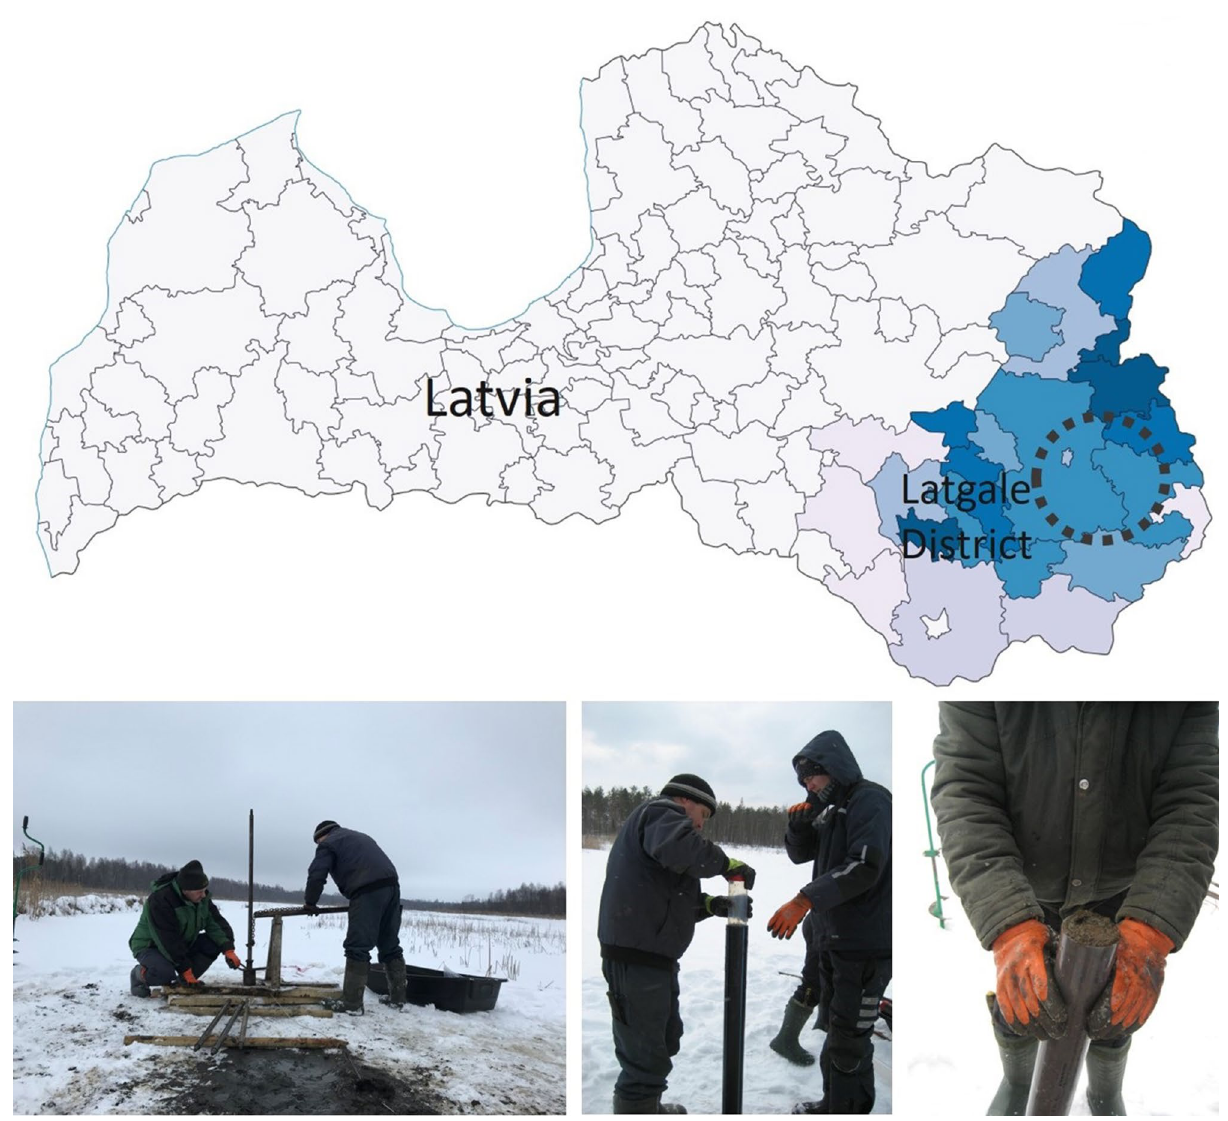
Figure 1. Sapropel extraction in Latgale District. Workers from geological research company “Geo Consultants, Ltd.” extract the samples. All pictures are the property of RSU Laboratory of Hygiene and Environmental